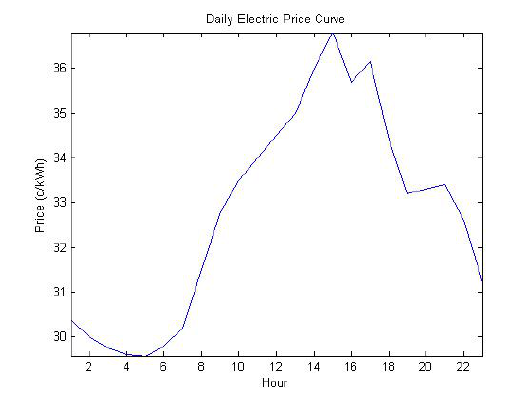
Figure 3: Daily Electricity Price Curve